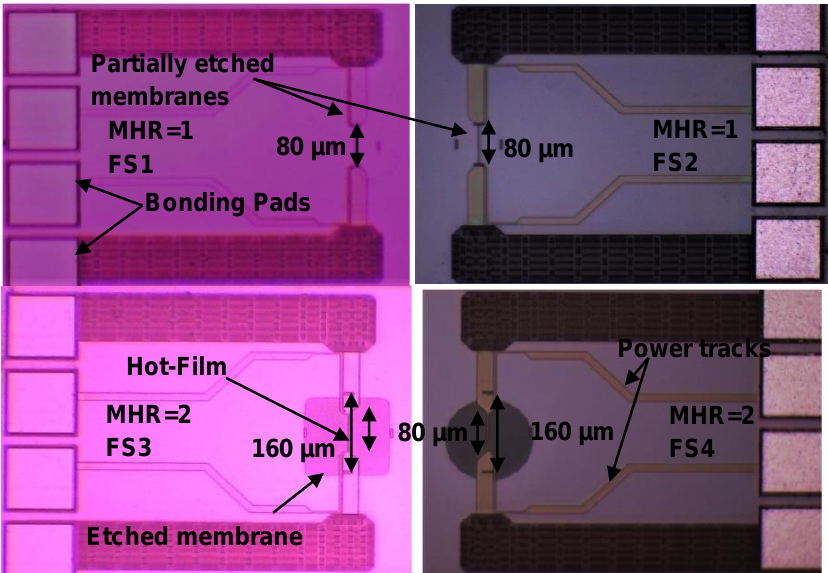
Figure 3. Optical micrographs (top view) of fabricated hot-film flow sensors having membrane to heater ratio 𝑀𝐻𝑅 = 1 (FS1 and FS2) and 𝑀𝐻𝑅 = 2 (FS3 and FS4).